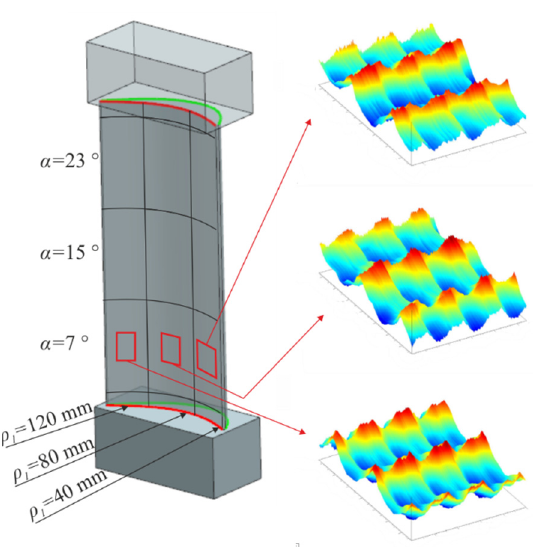
Figure 27. Topography of the concave surface when changing the curvature radius for the lead angle α = 7°.